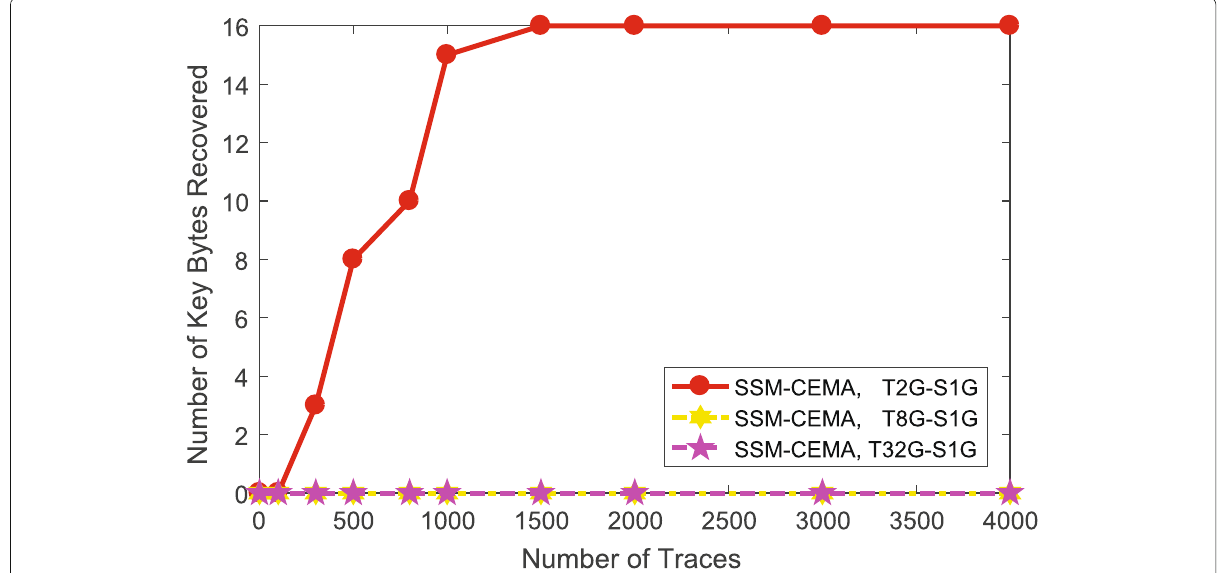
Fig. 8 The experimental results of SSM-CEMA in T 2 G - S 1 G , T 8 G - S 1 G and T 32 G - S 1 G encryption mode,